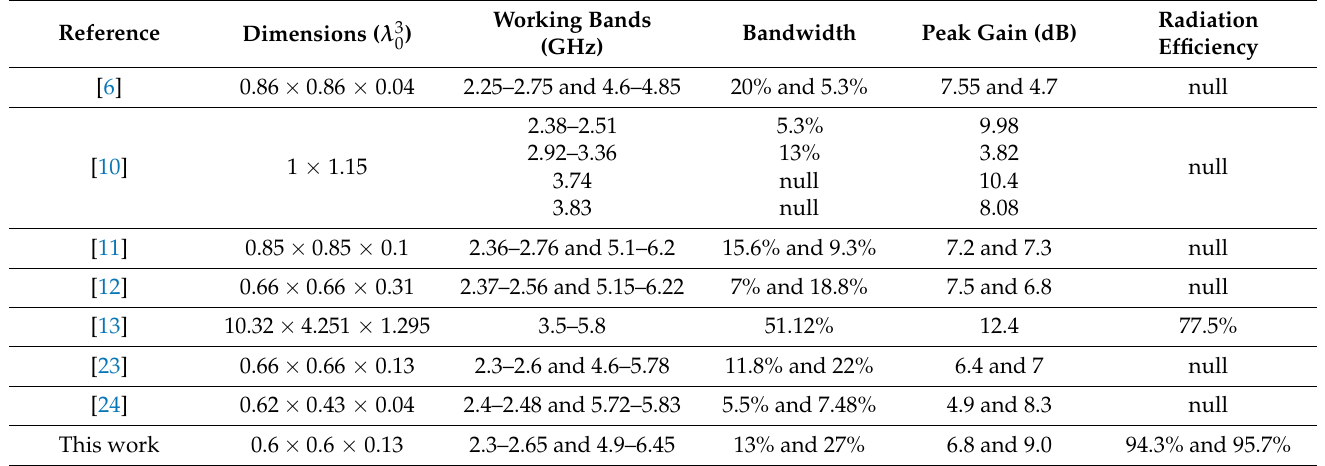
Table 3. Comparison of the proposed antenna with other